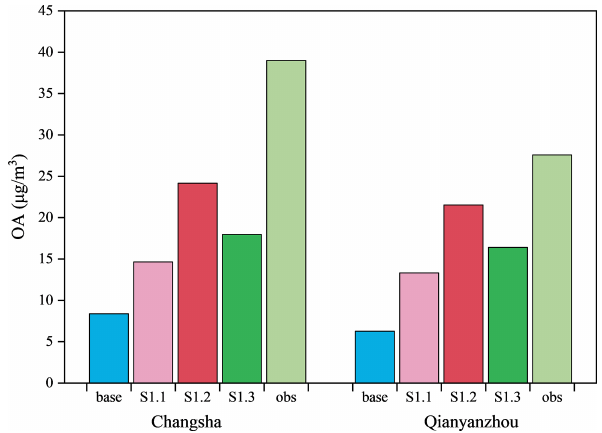
Figure 6. The observed and simulated OA concentrations for the sensitivity cases at Changsha and Qianyanzhou on 3 November